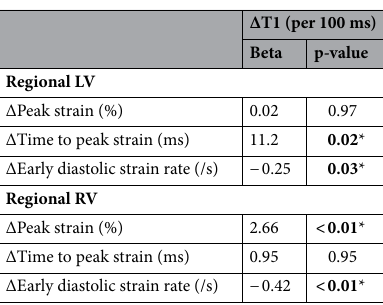
Table 3. Linear relationship of regional parameters with ΔT1. Linear relationship of regional function parameters in comparison regional changes in regional tissue water content demonstrated by T1 (per Δ100 ms) from the respective ventricle. *p < 0.05. Significant values are in